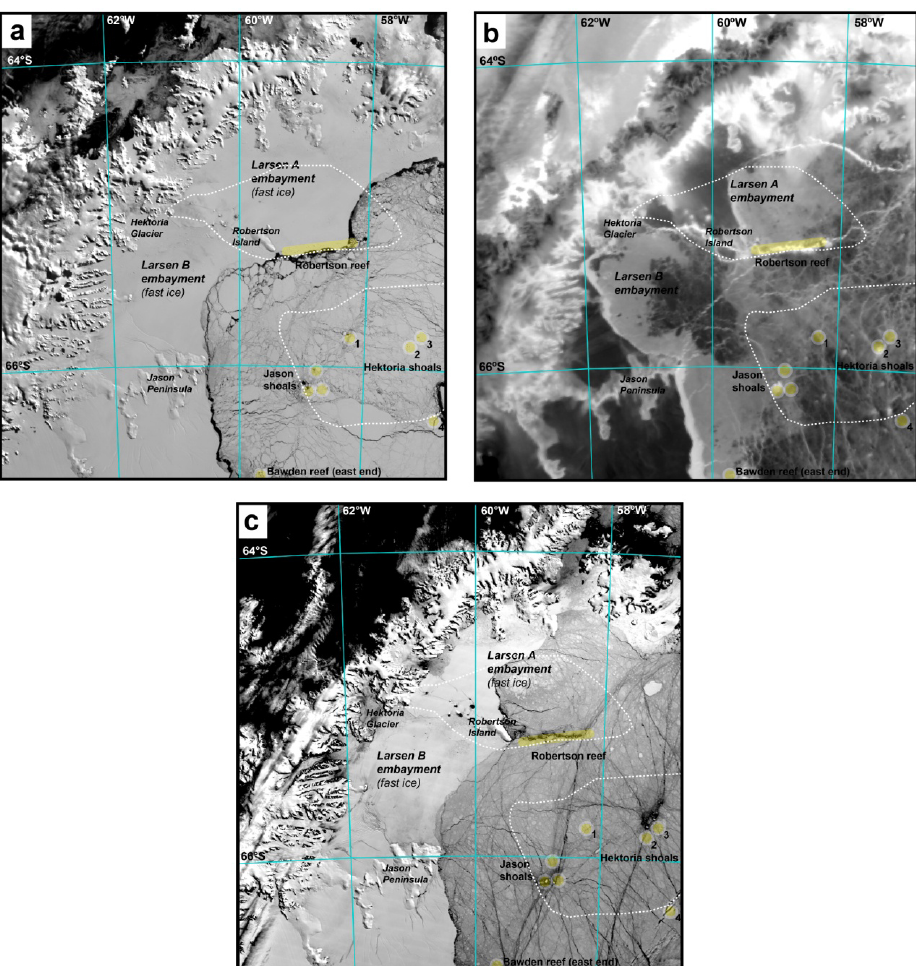
Figure 7. MODerate-resolution Imaging Spectroradiometer (MODIS, 36-band spectrometer) images showing unequivocal evidence of sev- eral shoal and reef areas (yellow circle) in the northwestern Weddell Sea, based on sea ice drift and grounding of small icebergs (see also Table 1). The shelf ice domes Hektoria and Robertson are showed in dashed white lines. (a) 5 October 2007, band number (BN) 02